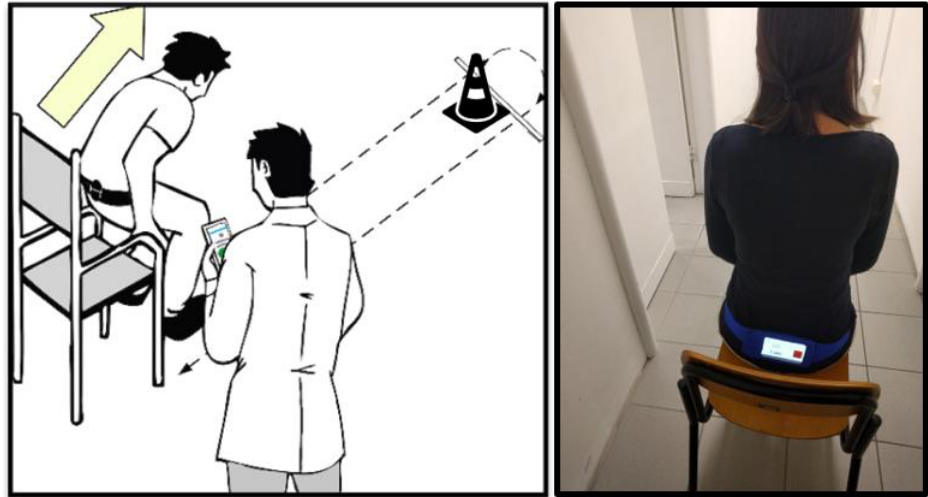
Figure 1. Illustration of the test set-up for the Timed Up and Go (iTUG).